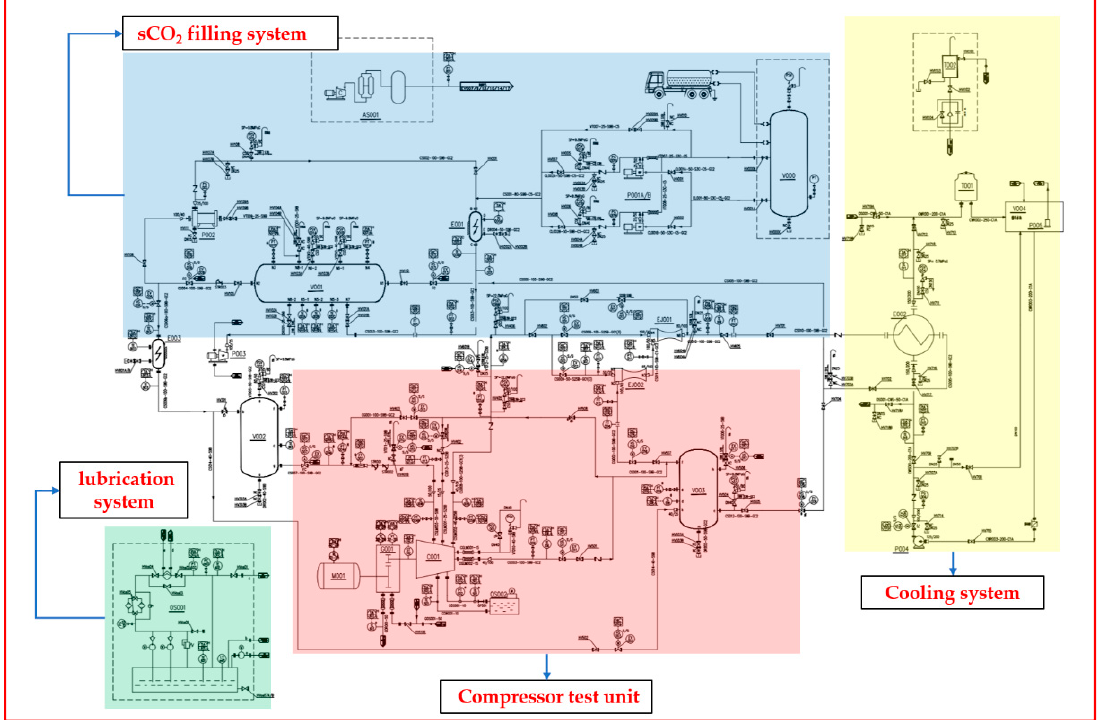
Figure 6. General experimental platform for the MWe sCO 2 compressor.